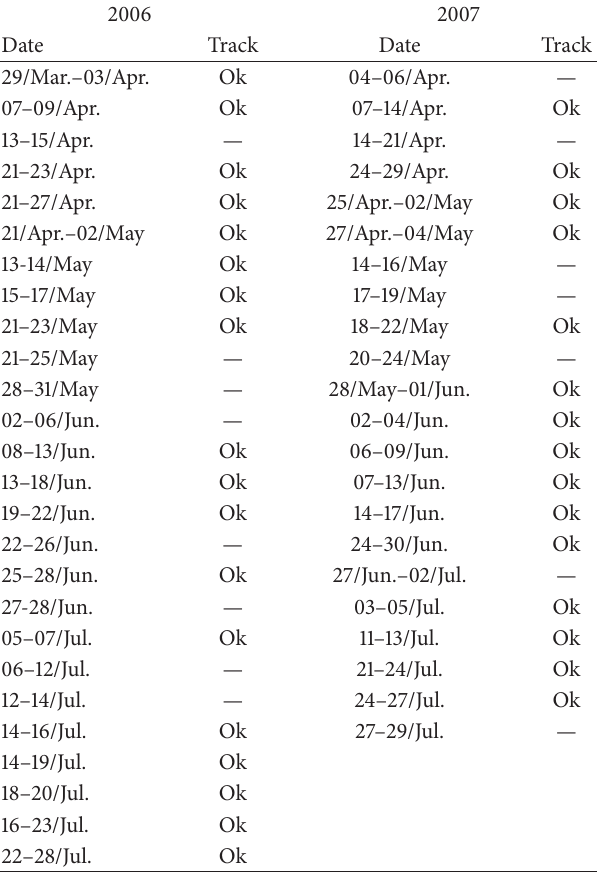
Table 1: Observed EWDs dates to the 2006 and 2007 rainy season (AMJJ) (left columns) and tracked by TracKH (right